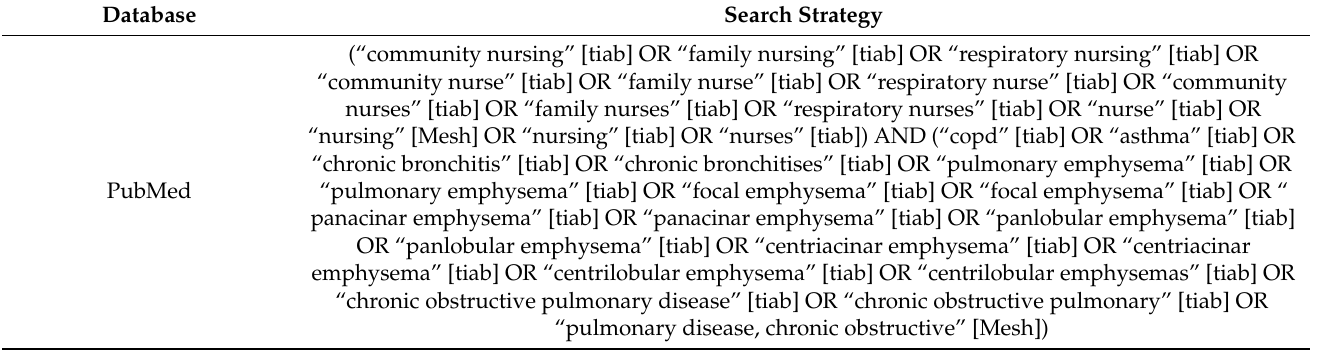
Table 1. Search strategy used for each